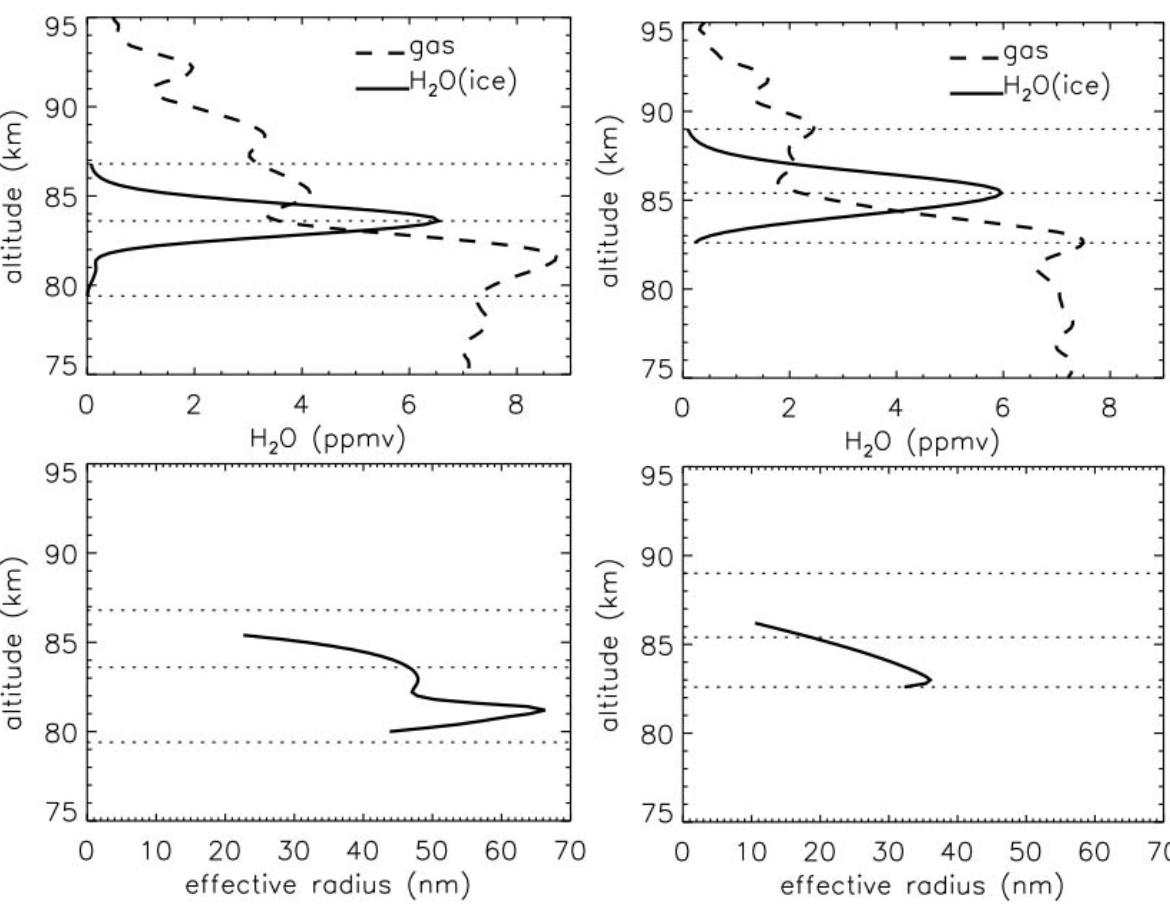
Fig. 12. SOFIE observations on 3 August 2007 nearest to the MASS1 flight, 20:35UTC at 71.3 ◦ N, 30.4 ◦ E (left panel) and at 22:12UTC at 71.3 ◦ N, 6.3 ◦ E (right panel). Horizontal dotted lines indicate Z top , Z max , and Z bot determined from H 2